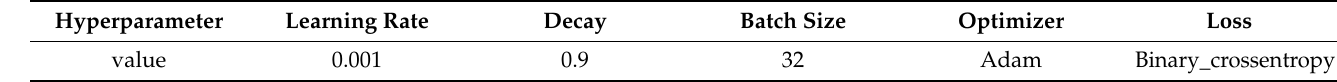
Table 1. Hyperparameters in experiment for